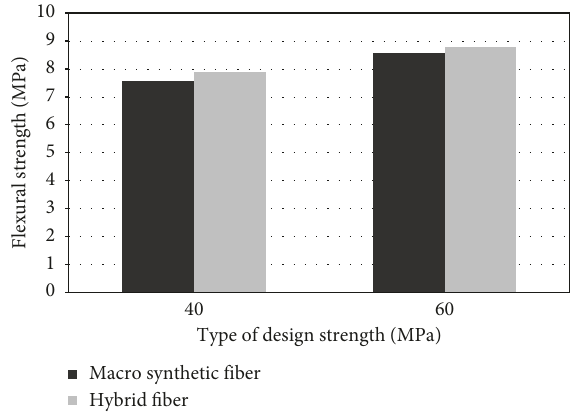
Figure 6: Flexural strength of the optimum mixture.